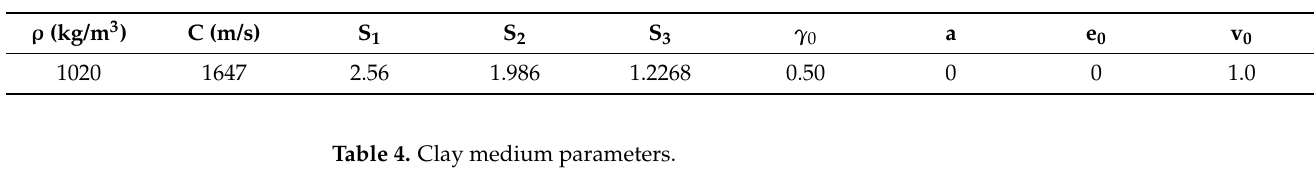
Table 3. Water medium parameters.